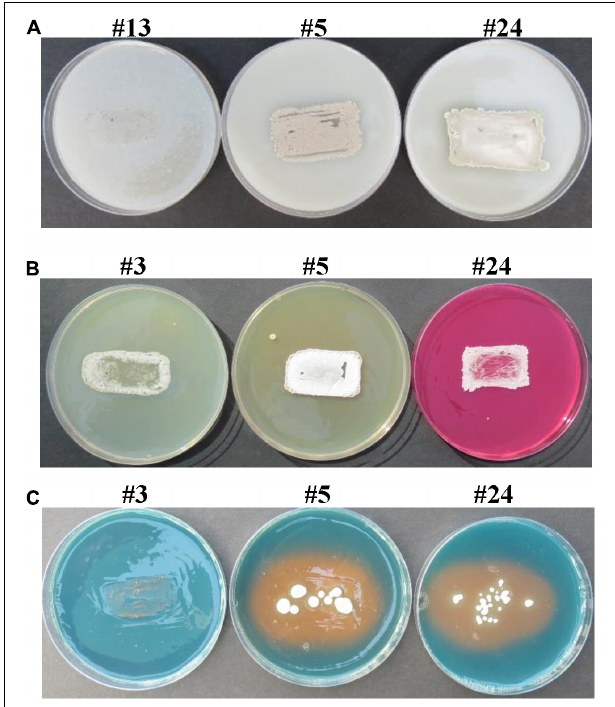
FIGURE 1 | In vitro screening of selected endophytic actinobacteria for salinity tolerance and PGP activities. Actinobacterial isolates possessing (A) salinity tolerance; and production of (B) Put and (C) siderophores. In (A) , actinobacteria #5 and #24, but not #13 (non-halotolerant control), were considered salt-tolerant isolates due to growth and heavy sporulation on inorganic salt starch agar supplemented with 8% NaCl. In (B) , isolates were tested on Moeller’s decarboxylase agar medium amended with L -arginine-monohydrochloride; and the change from yellow to red color of the phenol-red in isolate #24, but not #3 or #5, indicated production of PA, Put. In (C) , isolates were tested on chrome azurol S agar plates; and yellow halo surrounding the colony of #5 and #24, but not #3 (control), indicated the excretion of siderophores. Note that isolate #3 was considered as a halotolerant Streptomyces sp. Isolate #24 represents the endophytic PA-producing Streptomyces mutabilis UAE1, while #5 represents the endophytic PA-non-producing Streptomyces sp. 19-388. PGP, plant growth promoting; PA, polyamine; Put, putrescine.